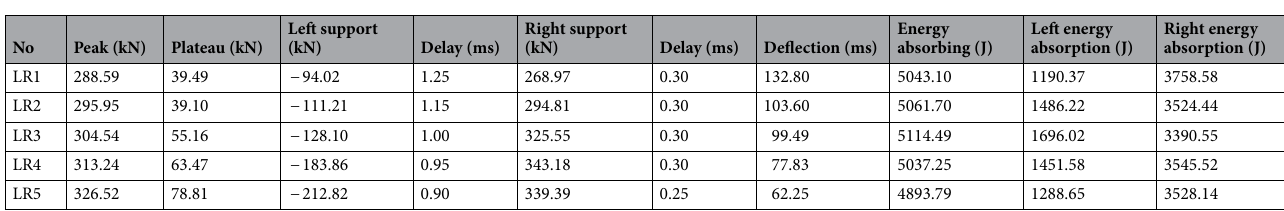
Table 6. Relevant data statistics of members with different longitudinal reinforcement ratios. The downward direction of the impact is positive, and the upward direction of the reaction force is